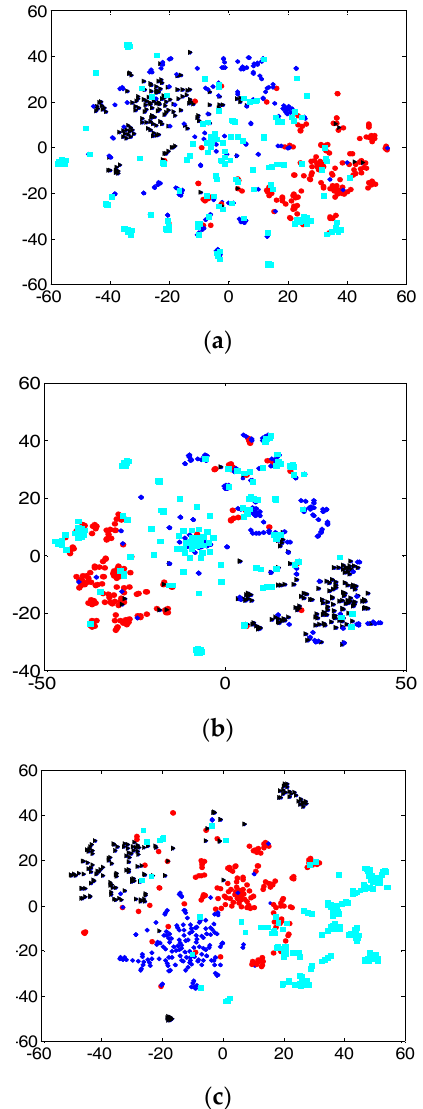
Figure 3. 2D Visualization on Citeseer. ( a ) Citeseer visualization using DeepWalk; ( b ) Citeseer visualization using node2vec; ( c ) Citeseer visualization using MVNR.